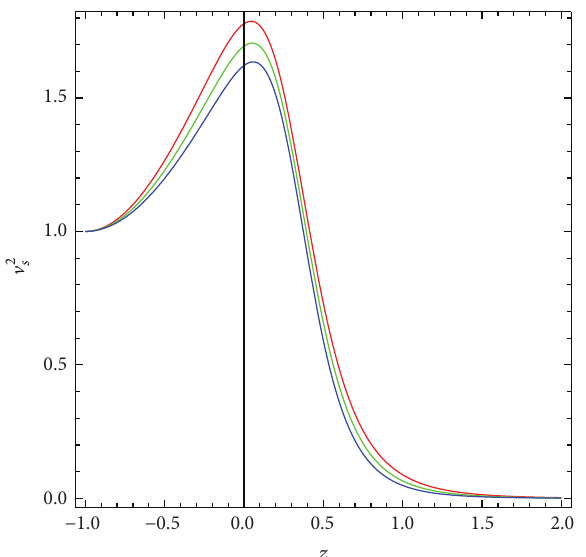
Figure 6: Plot of V 2 𝑠 versus 𝑧 for PDE parameter 𝑢 = −2 with 𝑚 = 2 (red), 𝑚 = 2.2 (green), and 𝑚 = 2.4